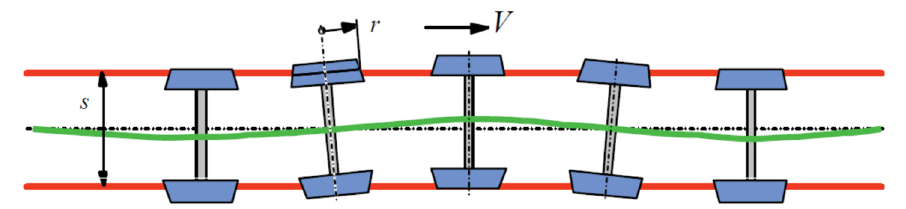
Figure 1. The kinematic oscillating motion around the center line of the track.